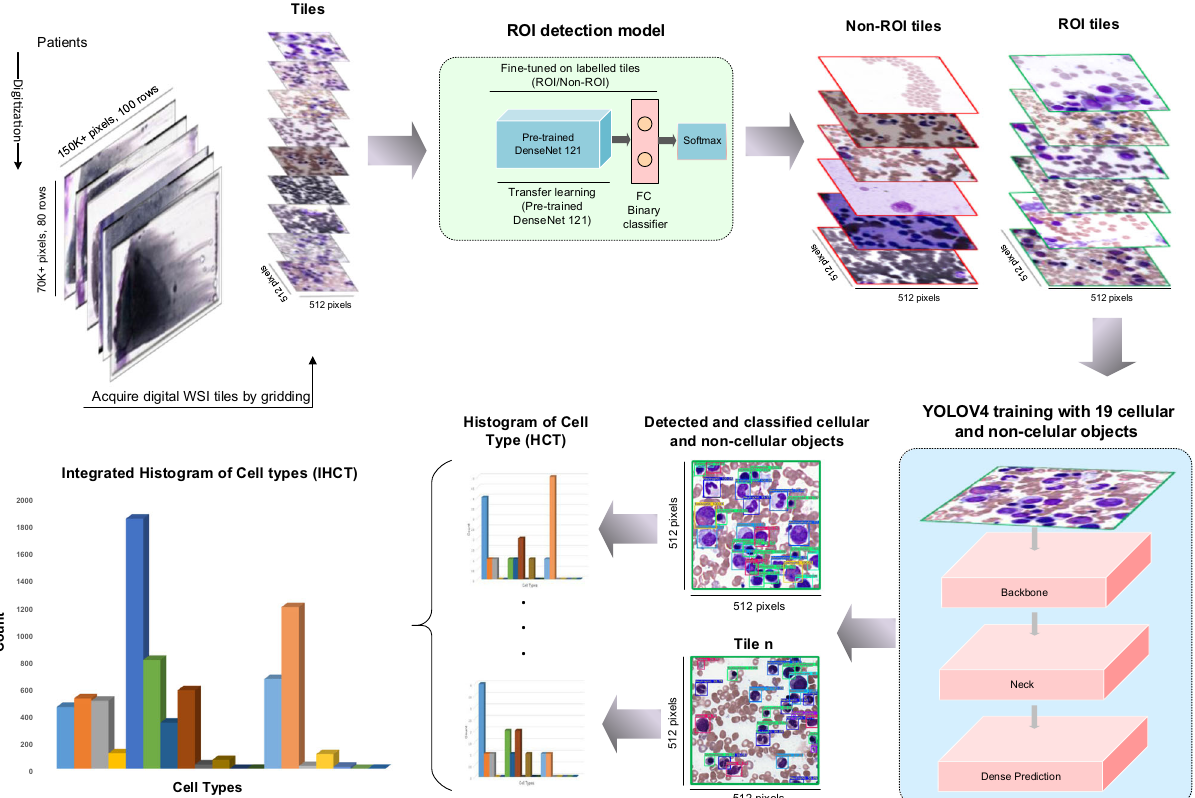
Fig. 1 End-to-end AI architecture for bone marrow aspirate cytology. In this architecture, initially, our Region of Interest (ROI) detection model is run on unprocessed bone marrow aspirate WSI. A grid is created on an original Whole-Slide Image (WSI) and ROI tiles are selected using ROI detection model. Subsequently, a You-Only-Look-Once (YOLO)-based object detection and classi fi cation is run to localize and classify cells in the selected tiles and generate the Integrated Histogram of Cell Types